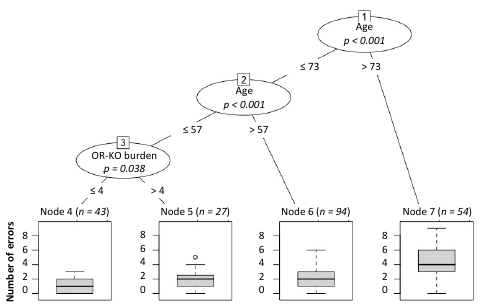
Figure 2. Binary tree computed by conditional recursive partitioning of the effect of OR-KO’s burden, sex, age, and population on the smell performance measured as mistakes in Sniffin’ sticks test. Smell errors were influenced by the combination of age and OR-KO genes’ burden. This analysis splits the sample into four final groups (labelled as Nodes 4–7). The group labelled Node 7 (n = 54), consisting of individuals aged >73, showed a median number of errors of 4 (IQR: 3–6). The group labelled Node 6 (n = 94), identified by individuals aged between 57 and 73, showed a median number of errors of 2 (IQR: 1–3) while for individuals aged ≤ 57 belonging to the Node 5 (OR-KO burden > 4, n = 27) and Node 4 (OR-KO burden ≤ 4, n = 43), the median number of errors was 2 (IQR: 1–2.5) and 1 (IQR: 0–2) respectively. p = p -value.